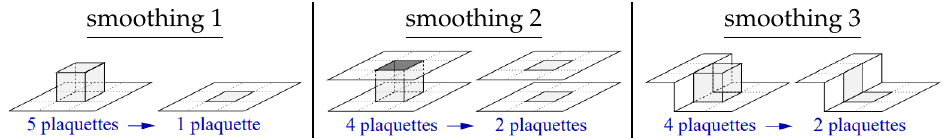
Figure 5. The effect of the smoothing procedures on the vortex surface is depicted, taken from Figure 5.8